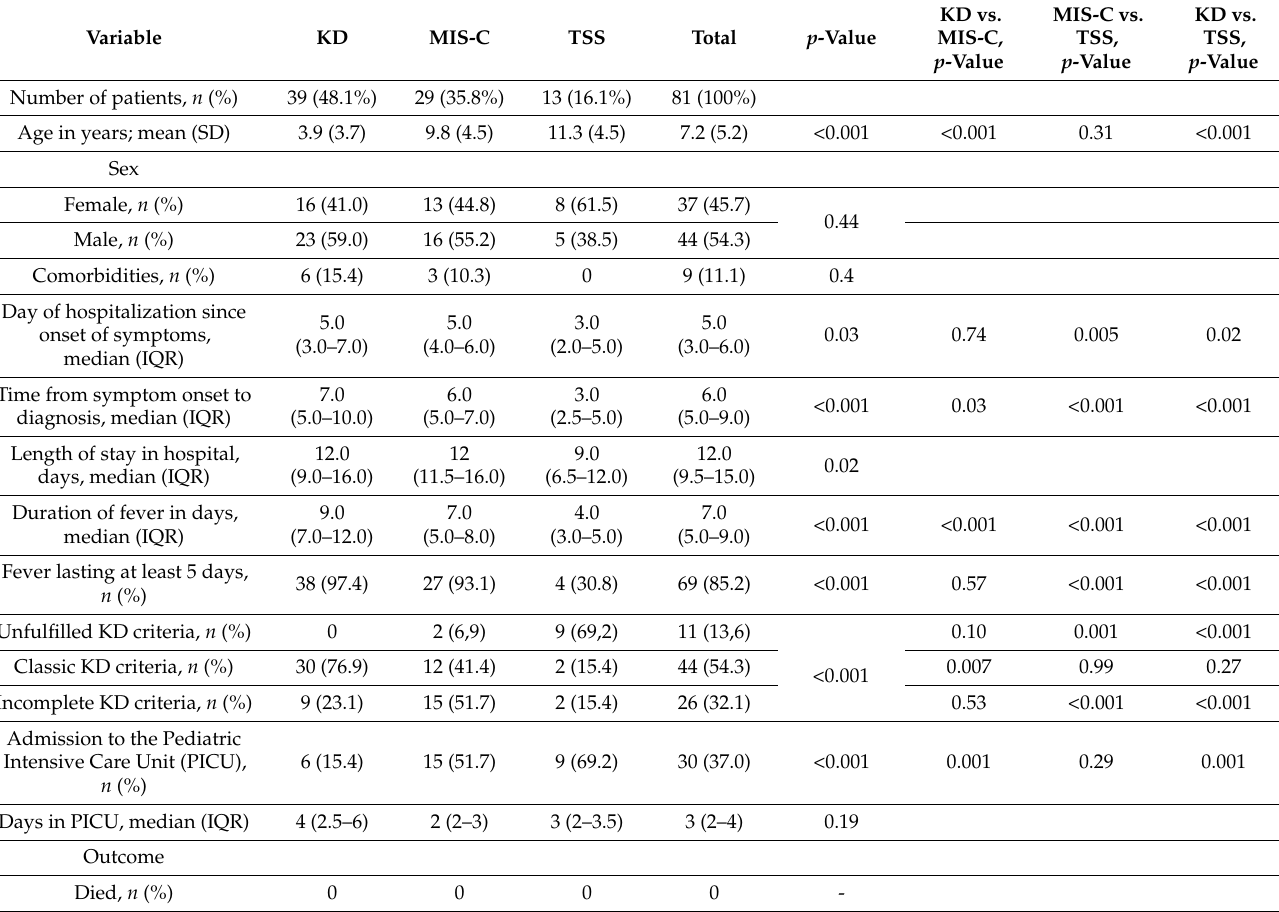
Table 2. Demographic features, comorbidities and clinical overview of MIS-C, KD and TSS